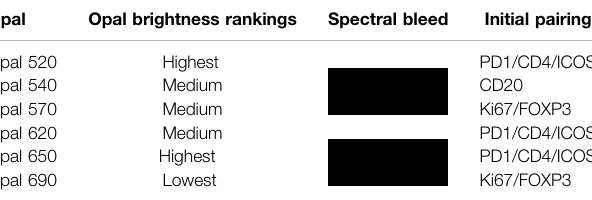
TABLE 1 | Antibody-Opal pairing strategy.